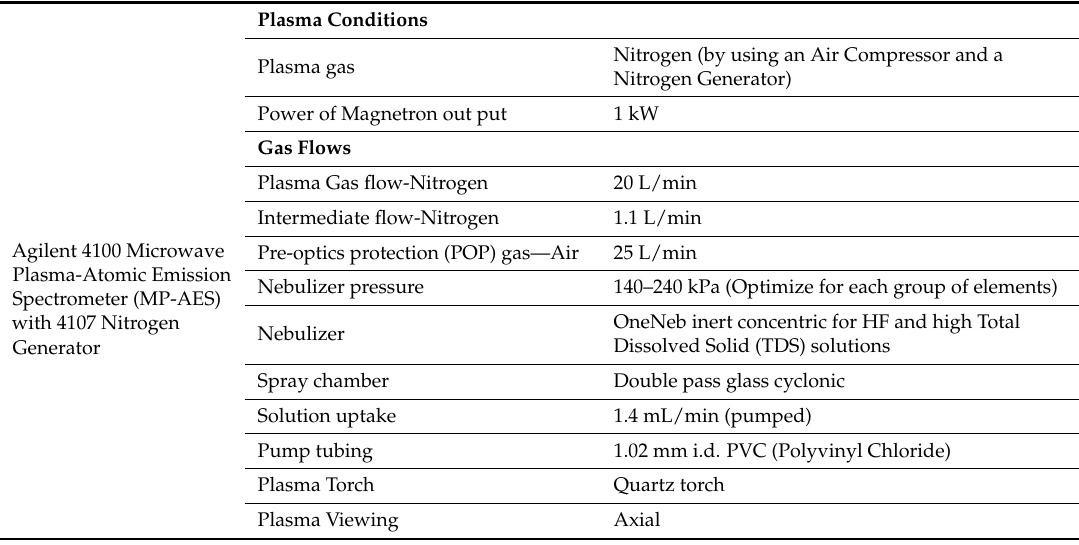
Table 1. Operating parameters of microwave plasma atomic emission spectrometry (MP-AES),